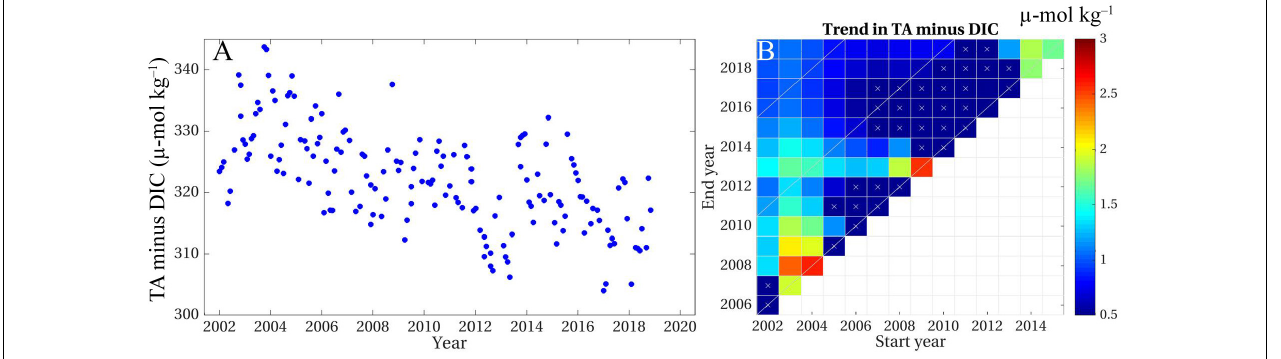
FIGURE 9 | The interannual variations of the monthly anomalies in TA minus DIC, which was a proxy of ocean acidification, based on the ship-based monthly TA and DIC measurements at ALOHA in surface waters (A) , and the corresponding interannual changing rates for a variety of periods starting between 2002 and 2015, and ending between 2006 and 2019 (B) . In (B) , the X-axis and Y-axis represent the start year and end year, respectively, of each rate analyzed, the diagonal lines (i.e., 5, 10, and 15 years) indicate the length of trend periods, and a white cross is superposed on the plot when the p -value was >